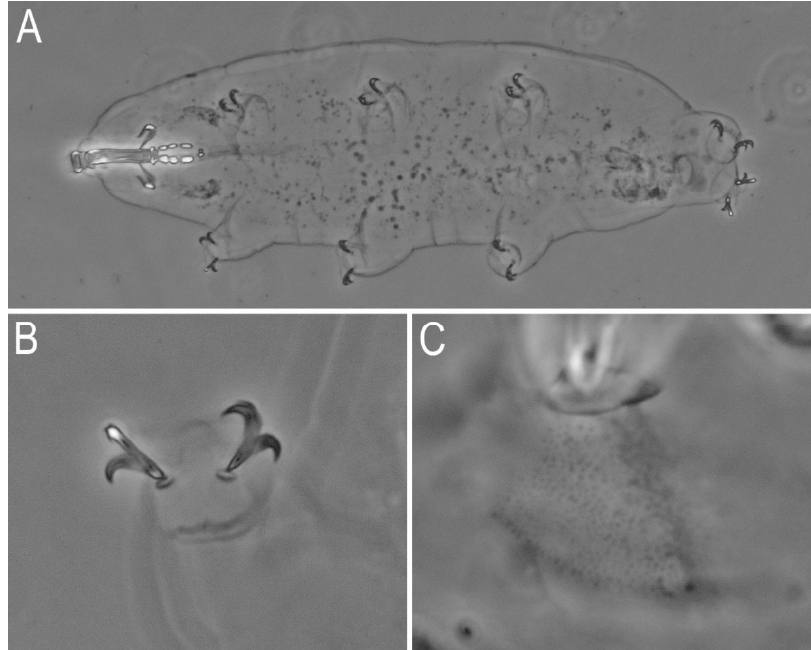
Figure 2. Paramacrobiotus fairbanksi (Polish population). ( A) Dorso-ventral projection of the entire animal; ( B) Claws I with smooth lunules; ( C) Granulation on leg IV with visible smooth lunulae. Scale bars in ( μ m). All PCM.